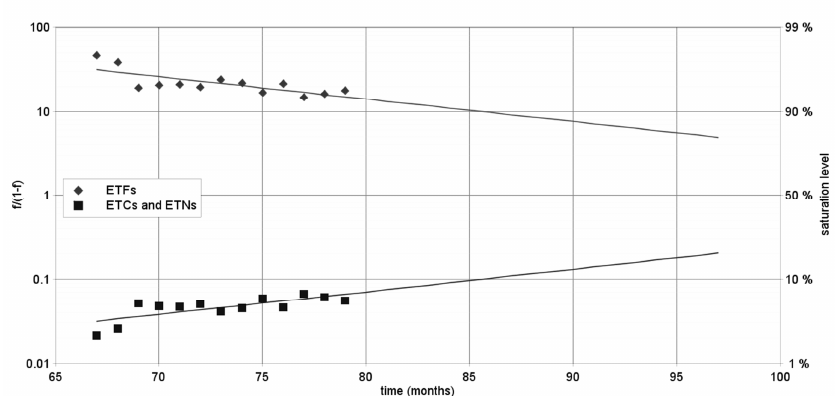
Figure 6. Exchange-traded products observed and predicted substitution patterns in Germany. December, 2015 — June, 2018